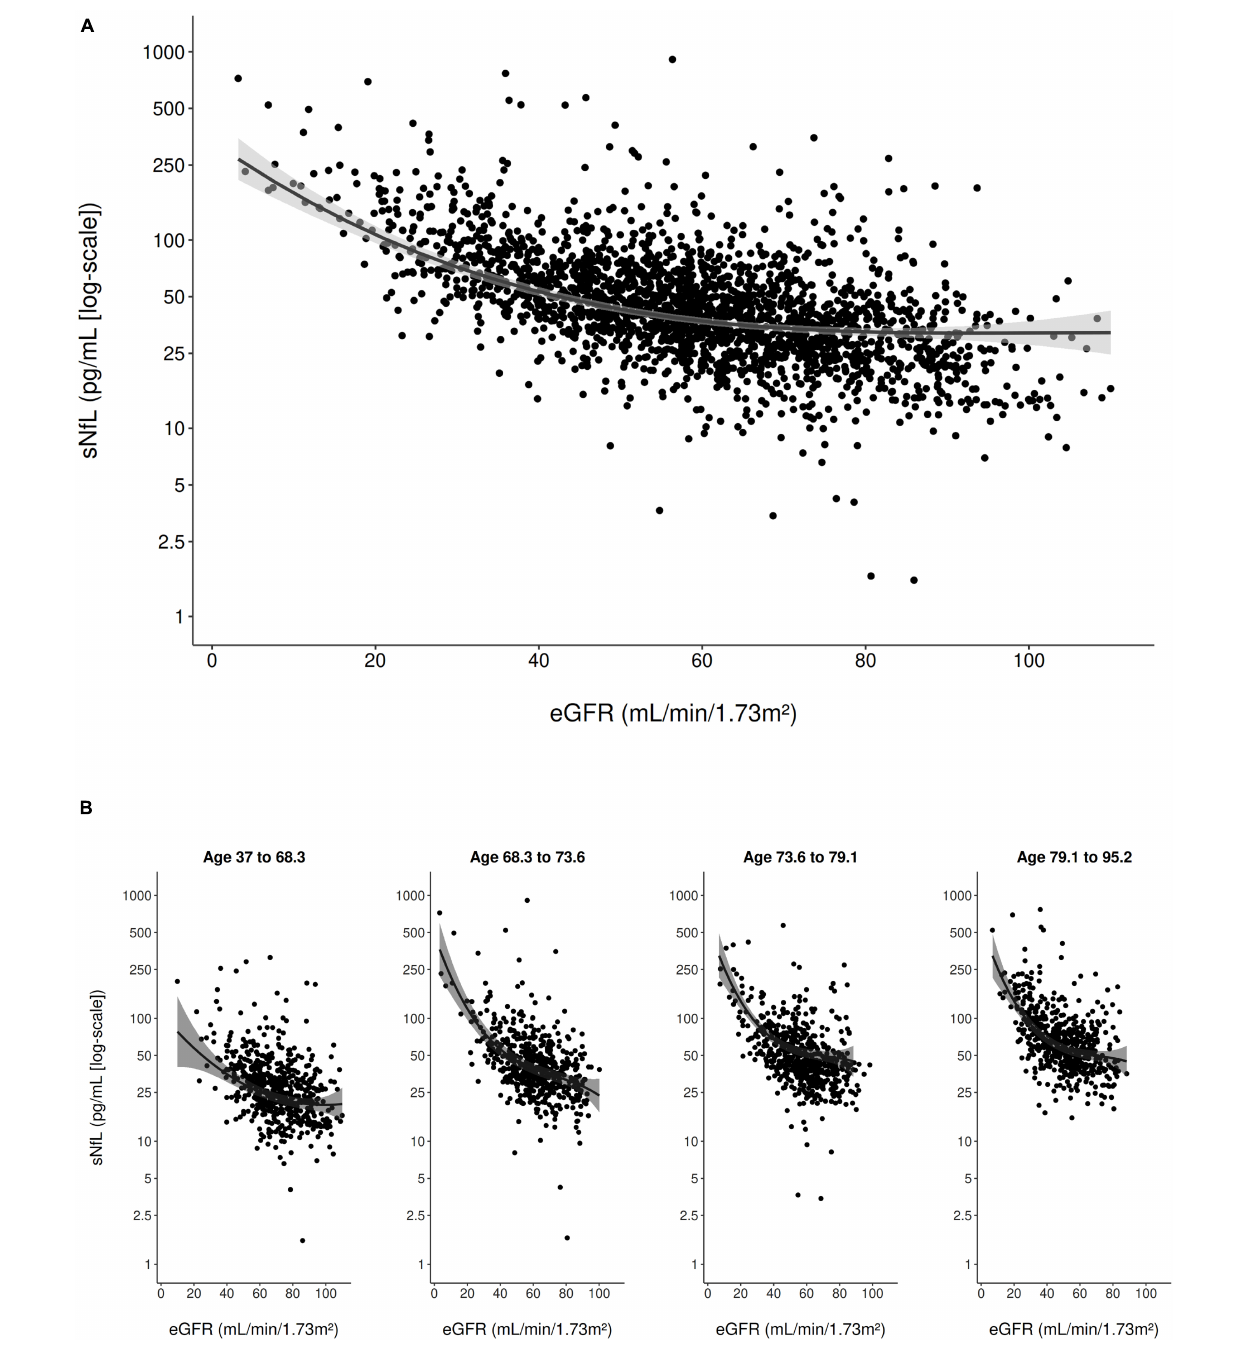
FIGURE 1 | Scatter plot of the association of eGFR crea with sNfL (using the log scale) in the entire study population (A) and stratified to age quartiles (B) . The solid line represents the predicted values from the main multivariable model and the gray shading represents the 95% confidence